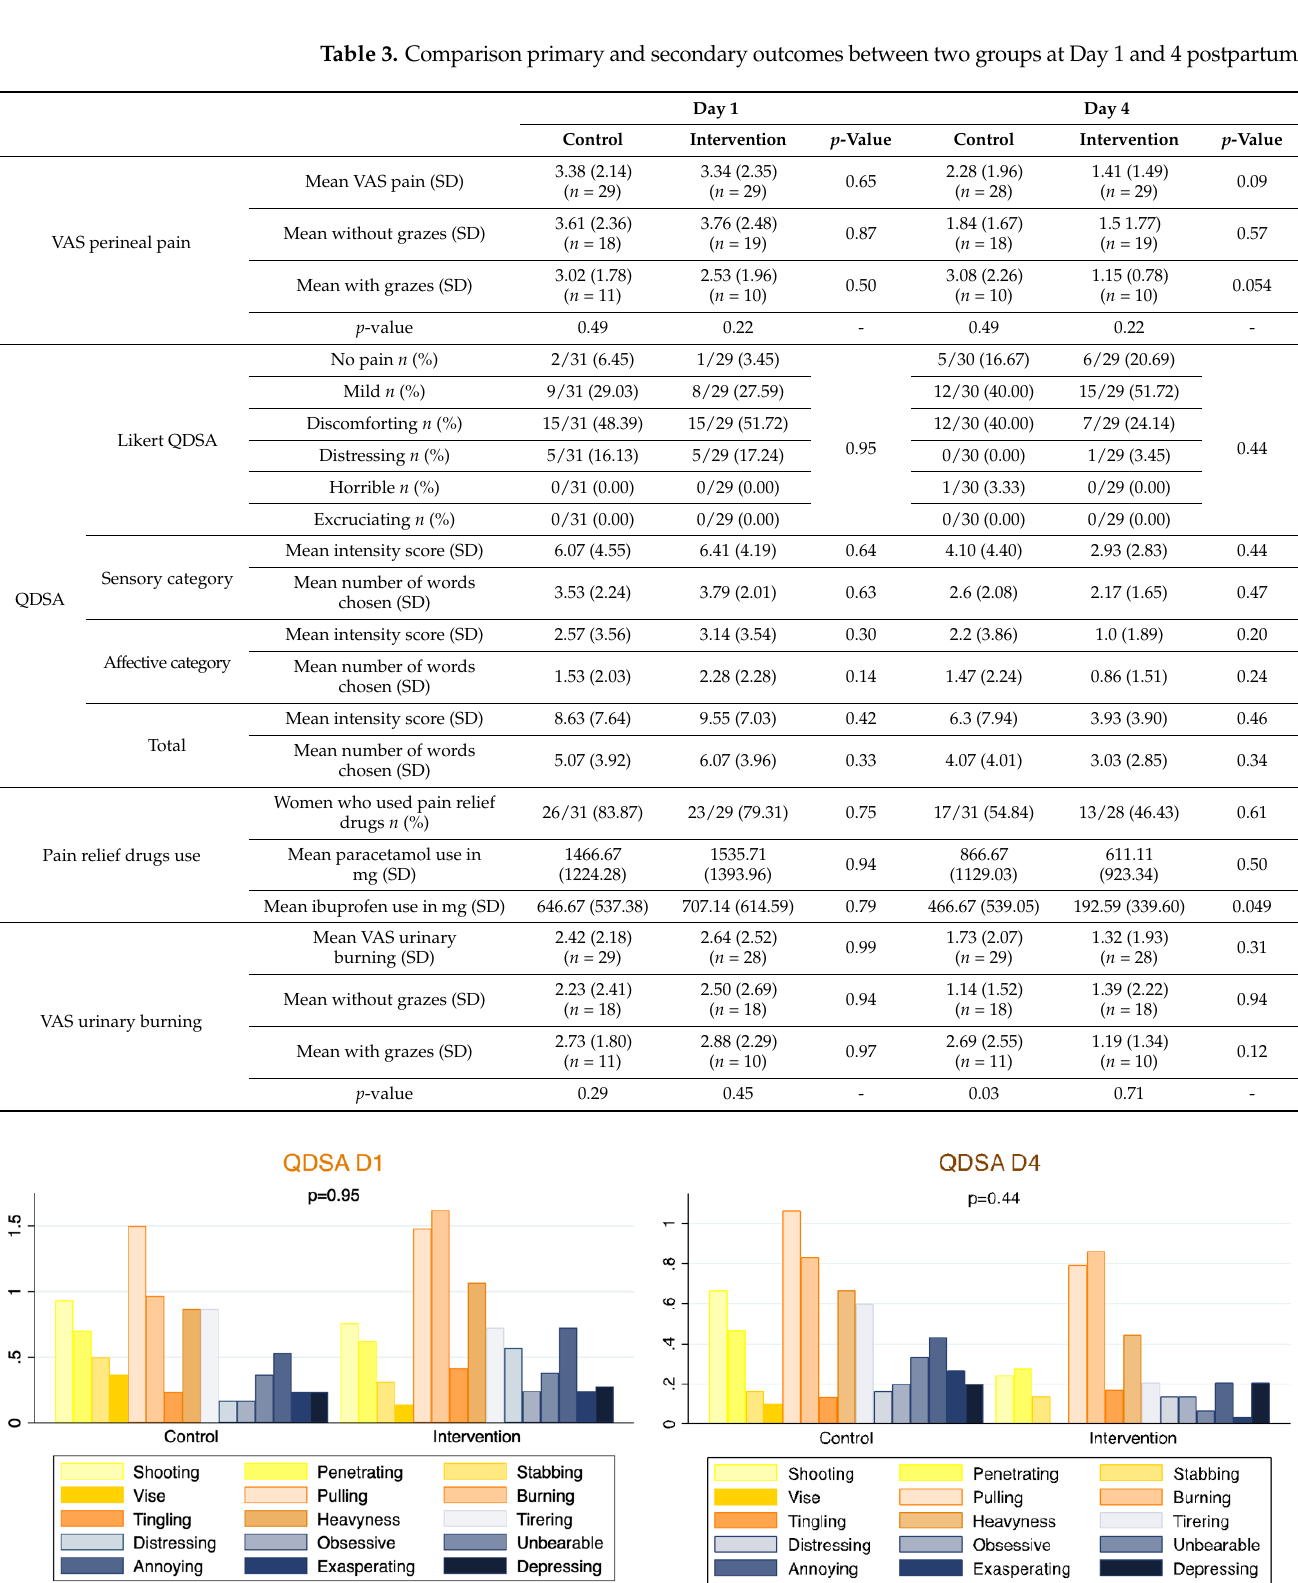
Figure 2. Questionnaire De Saint Antoine (QDSA) responses.